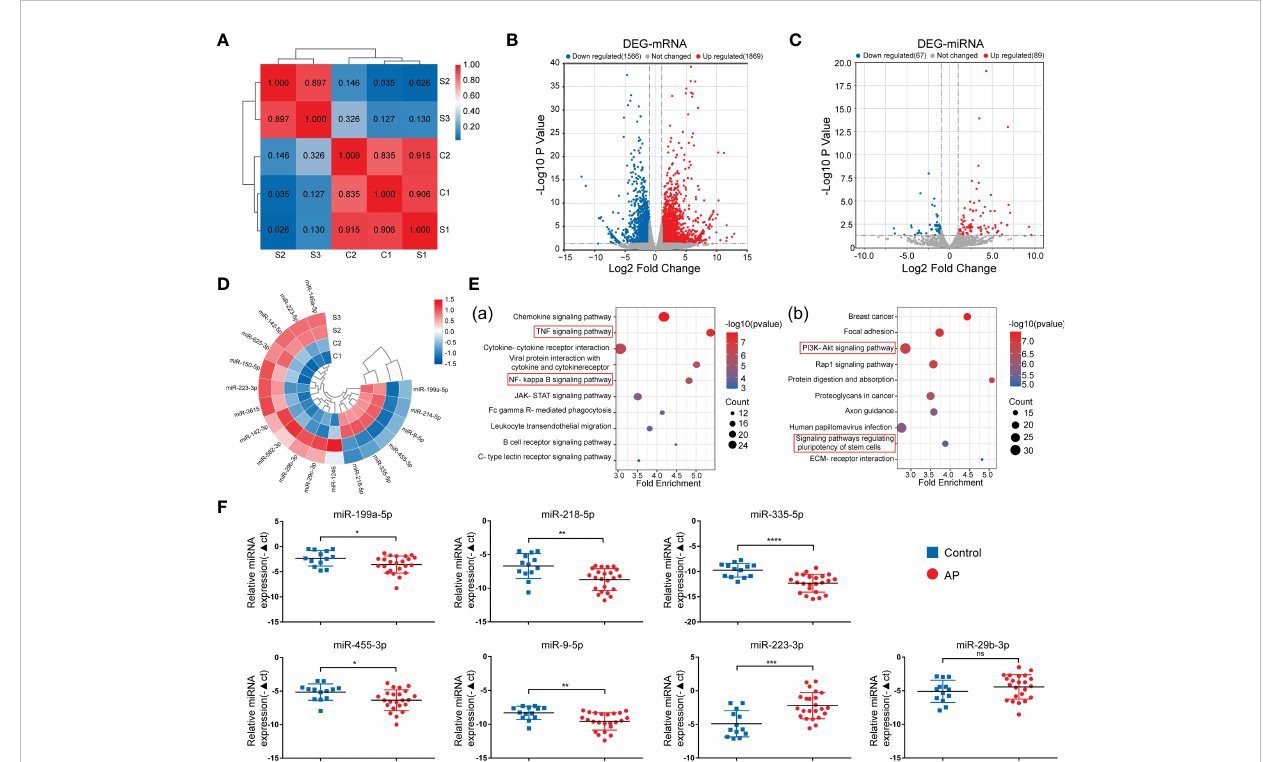
FIGURE 1 Identi fi cation of DE-miRNAs in periapical tissue. (A) Correlation analysis of the sequenced samples. (B) Volcano diagram of DE-mRNAs. (C) Volcano diagram of DE-miRNAs. (D) Circular heatmap of 12 up-regulated and 6 down-regulated miRNAs. (E) KEGG pathway enrichment analysis of the intersection genes between the DE-mRNAs and the predicted target genes of DE-miRNA. (F) Relative expression of the seven miRNAs in samples of periapical tissues (AP/Control:23/13). Data were presented as the mean ± SD. * p < 0.05, ** p < 0.01, *** p < 0.001, and **** p < 0.0001, ns, no signi fi